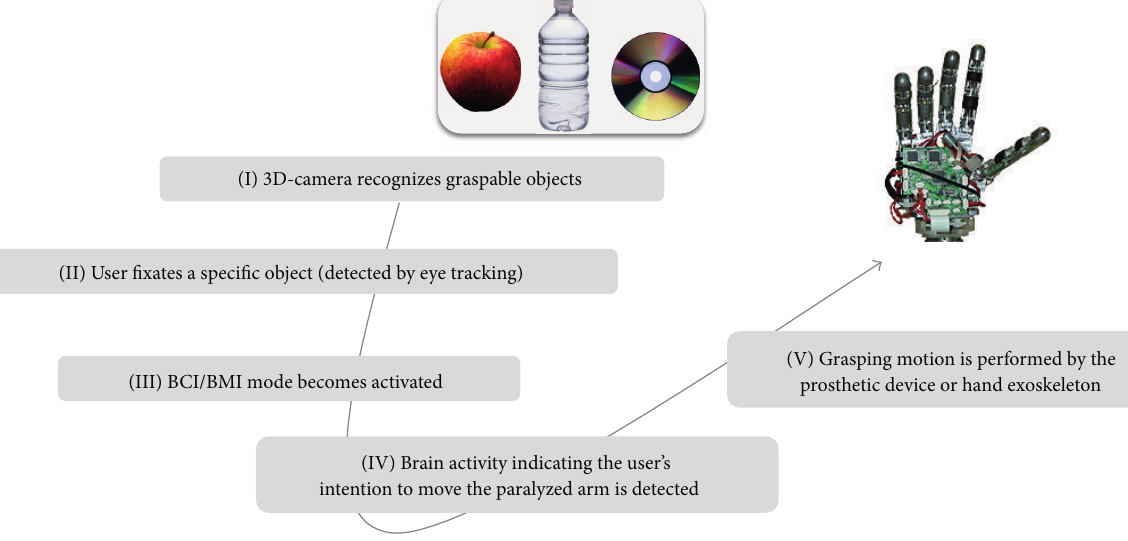
Figure 2: Illustration of the processing chain for performing grasping motions of an assistive system using brain waves and eye movements. The grasping motion stops once the user does not fixate the object with his eyes